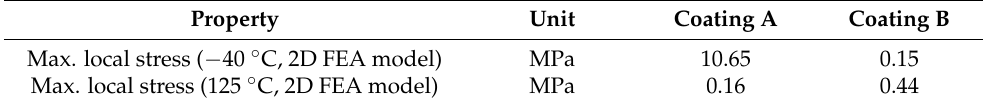
Table 9. Conformal coating max. local stress by 2D FEA modeling of chip attached to PCB. Property